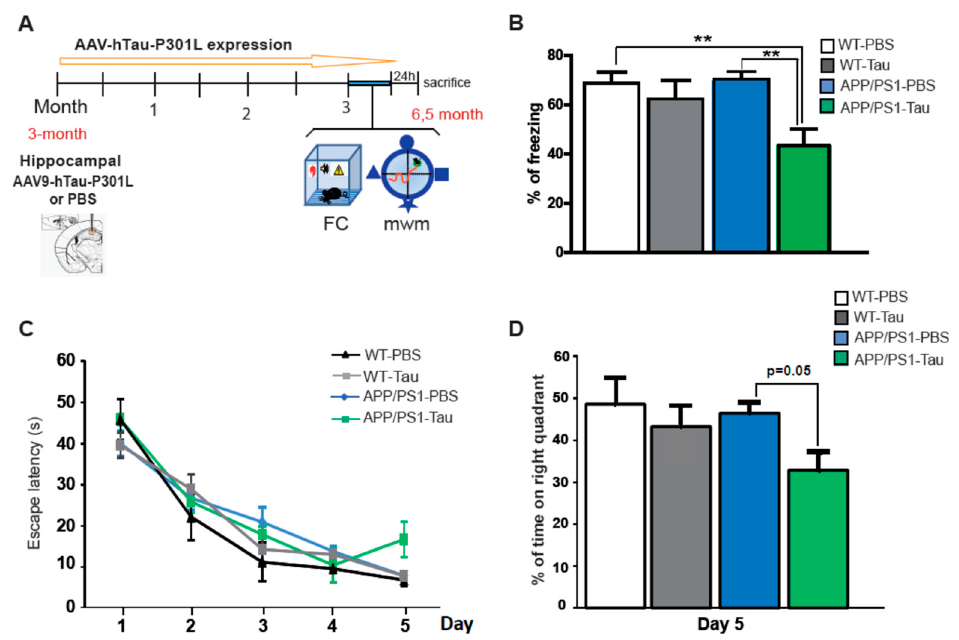
Figure 2. Wild type (WT) and APP/PS1 mice were injected with PBS or AAV9-hP301LTau in the hippocampus and analyzed 3 months later. ( A ) Scheme showing time-line for virus administration, behavioural tasks and sacrifice of mice. FC: fear conditioning, mwm: Morris water maze. ( B ) Freezing behaviour from WT and APP/PS1 mice treated with PBS or AAV9-hTauP301L. Data represent the percentage of time of freezing during the test. ( C ) Escape latency of the hidden-platform in the MWM test for the WT and APP/PS1 mice treated with PBS or AAV9-hTauP301L. ( D ) Percentage of time spent in correct quadrant during the probe test at Day 5. In all figures, results are expressed as mean ± SEM ( n = 10–12 per group). Two-way analysis of variance (ANOVA) and Tukey’s post-hoc test was used for statistical analyses, ** p ≤ 0.01.